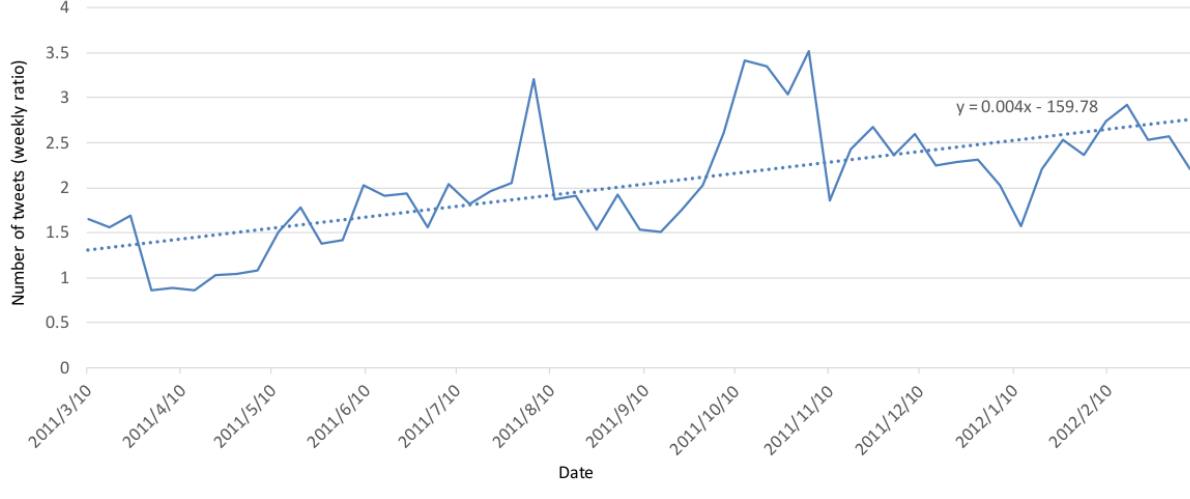
Figure 7. Weekly ratio of the number of tweets for Fukushima and other prefectures. The dotted line represents the linear